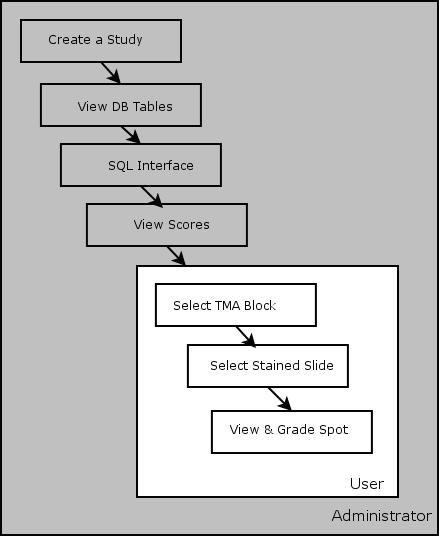
Options available to users through the VTM interface. Schematic diagram showing options available to Administrators and Users within the VTM interface.